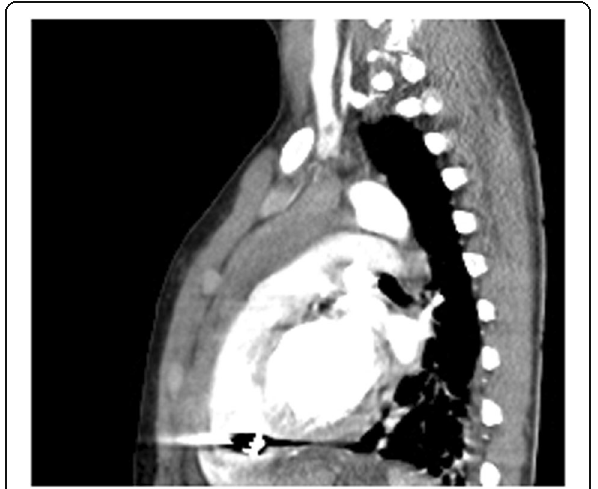
Fig. 2 Chest CT scan with contrast, sagittal view sowing the radio- opaque pellet in the right ventricular apex with shadow artefact